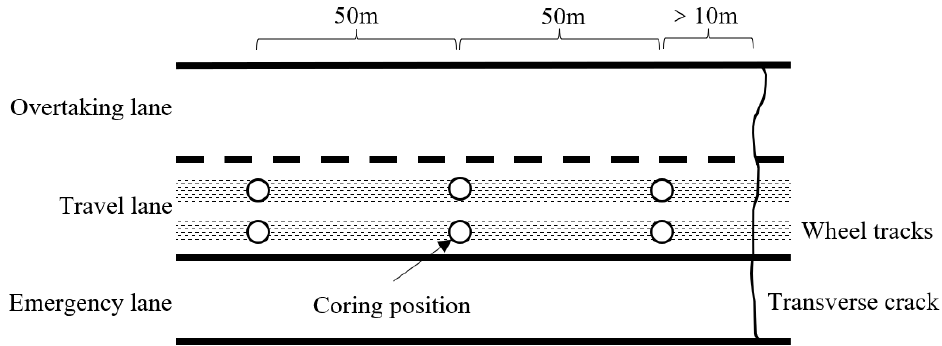
Figure 1. Schematic of coring position.